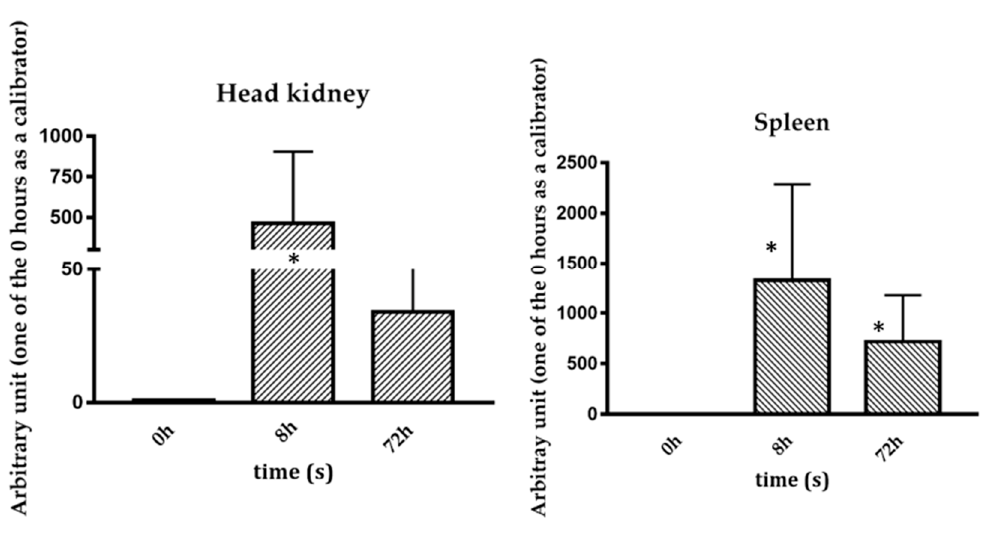
Figure 3. Trematocine expression analysis after in vivo immunization with Psychrobacter sp. TAD1 in head kidney and spleen after 8 h and 72 h. The results are expressed as mean + SD and the asterisk indicate the significance level with respect to control (0 h). * = p < 0.05.